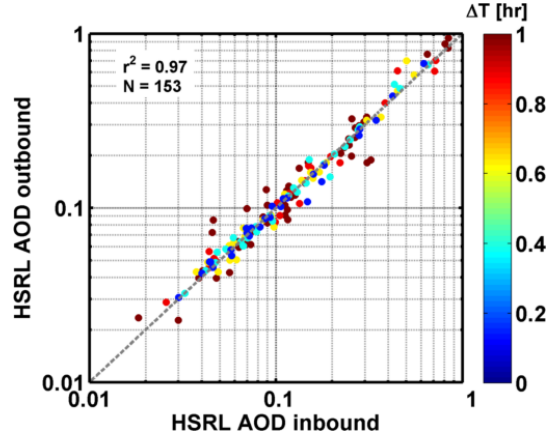
Figure 2. Spatially matched HSRL AOD measurements from out and back tracks with the color bar indicating the temporal separation of the measurements. The dashed line is the one-to-one